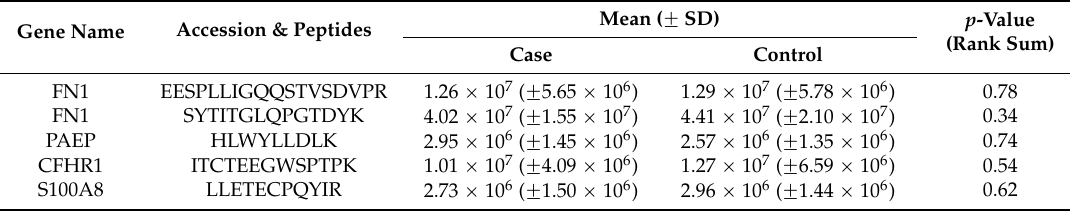
Table 5. Case-control comparisons among detected